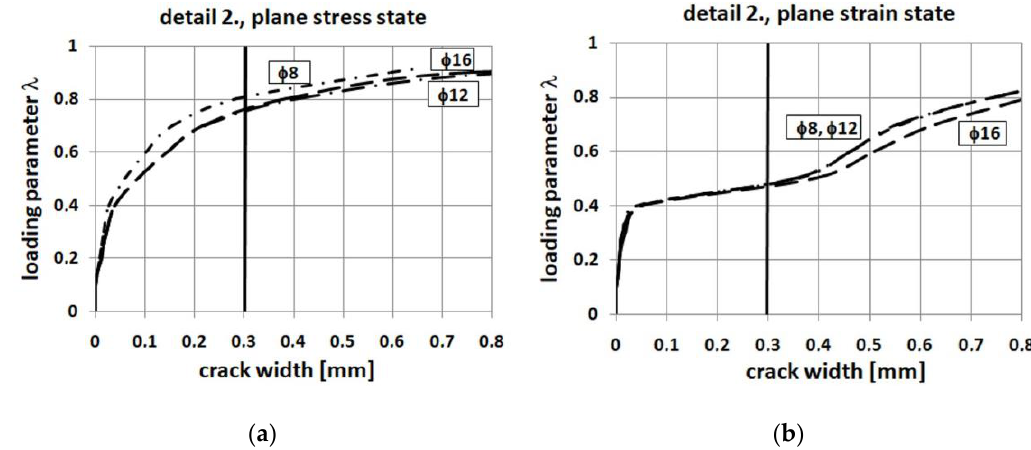
Figure 30. Crack width for different areas of diagonal reinforcement, ( a ) the plane stress state, ( b ) the plane strain state.